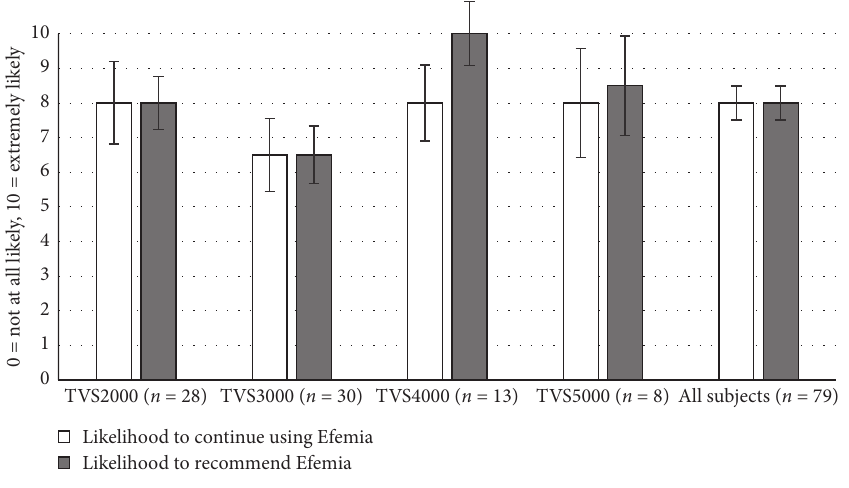
Figure 4: Median gradings of the questions: on a scale of 0–10, how likely are you to continue using Efemia or to recommend Efemia to a friend? Error bars � 95%